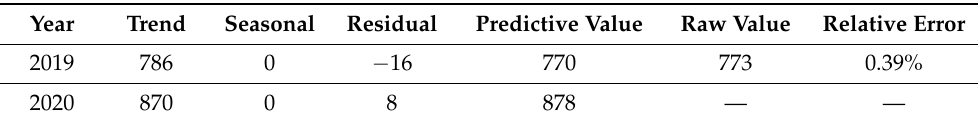
Table 5. Quarterly forecast and additional results of housing municipal engineering production safety accidents after trend decomposition.